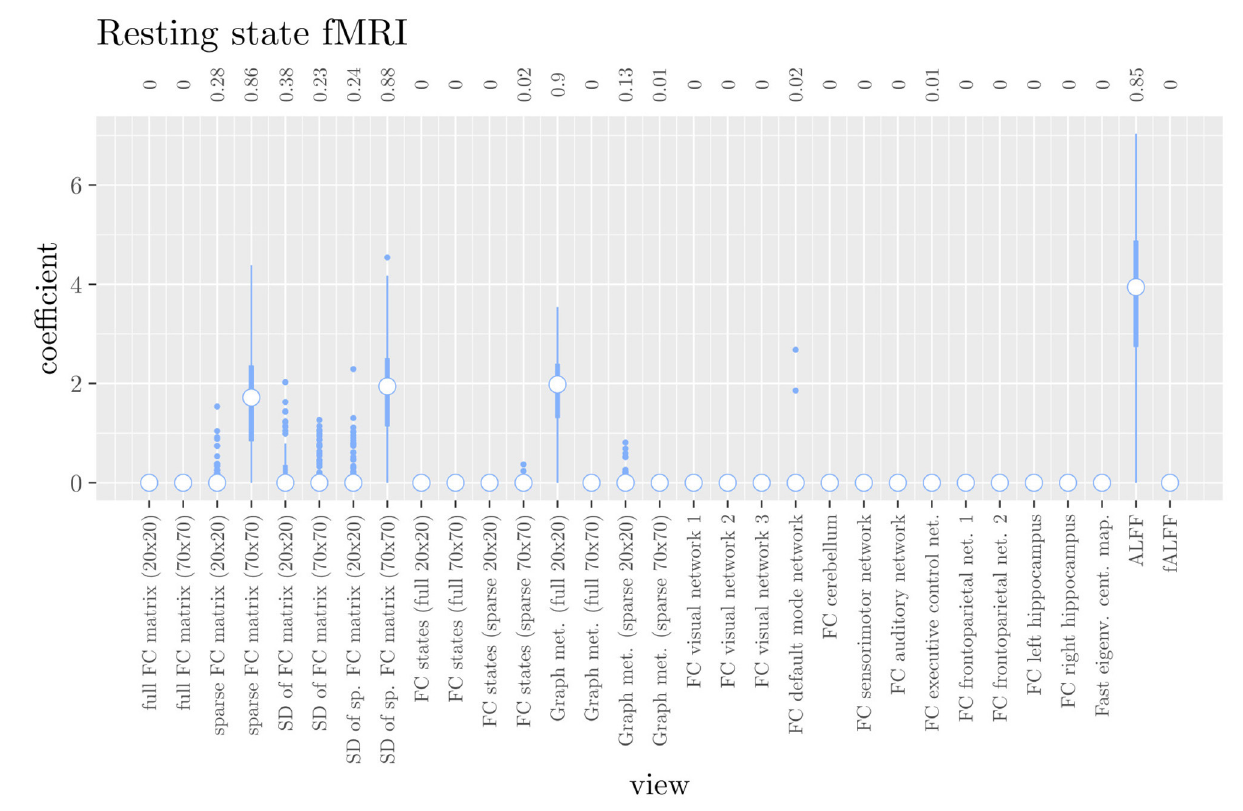
FIGURE 8 | Box plots of the hierarchical StaPLR intermediate-level regression coefficients for the functional scan type. The numbers at the top of the graph denote the proportion of times the coefficient was